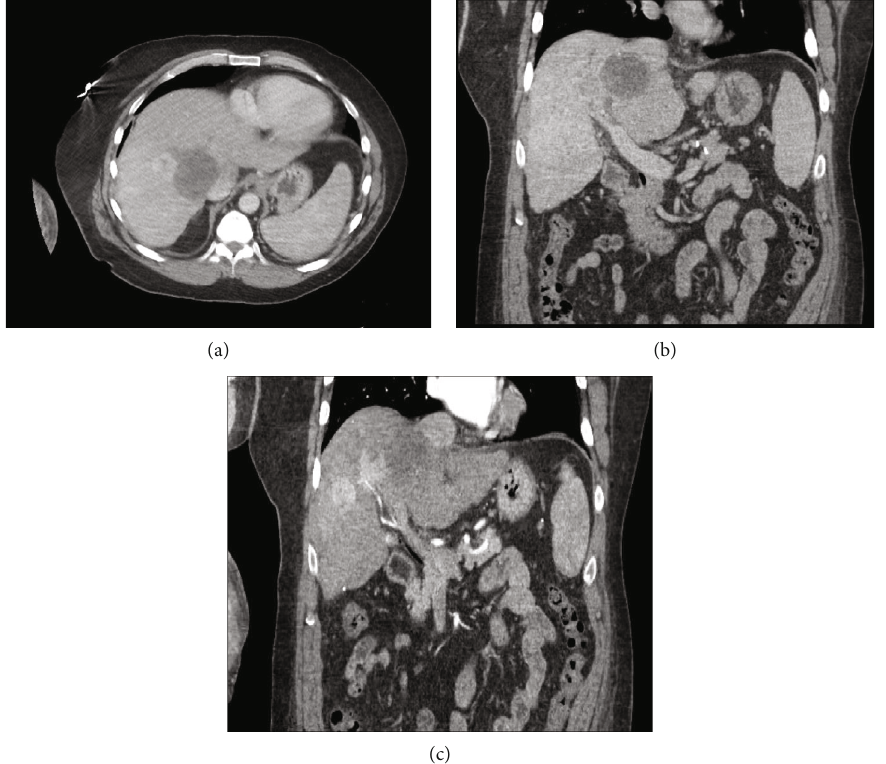
Figure 3: (a – c) Computerized tomography scan of abdomen and pelvis showing four liver lesions typical of HCC, with one hypoattenuating large lesion atypical for